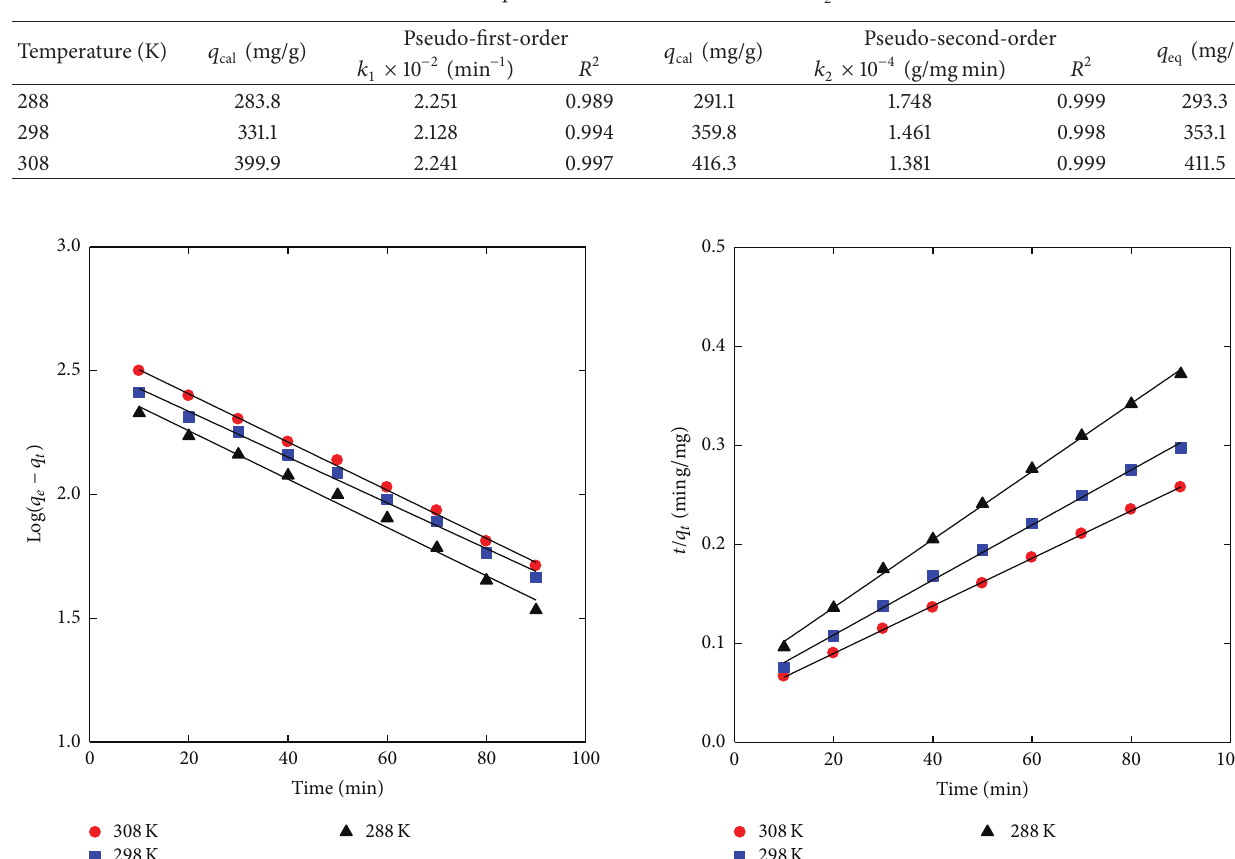
Table 2: Kinetic parameters of Gardenia blue on TiO